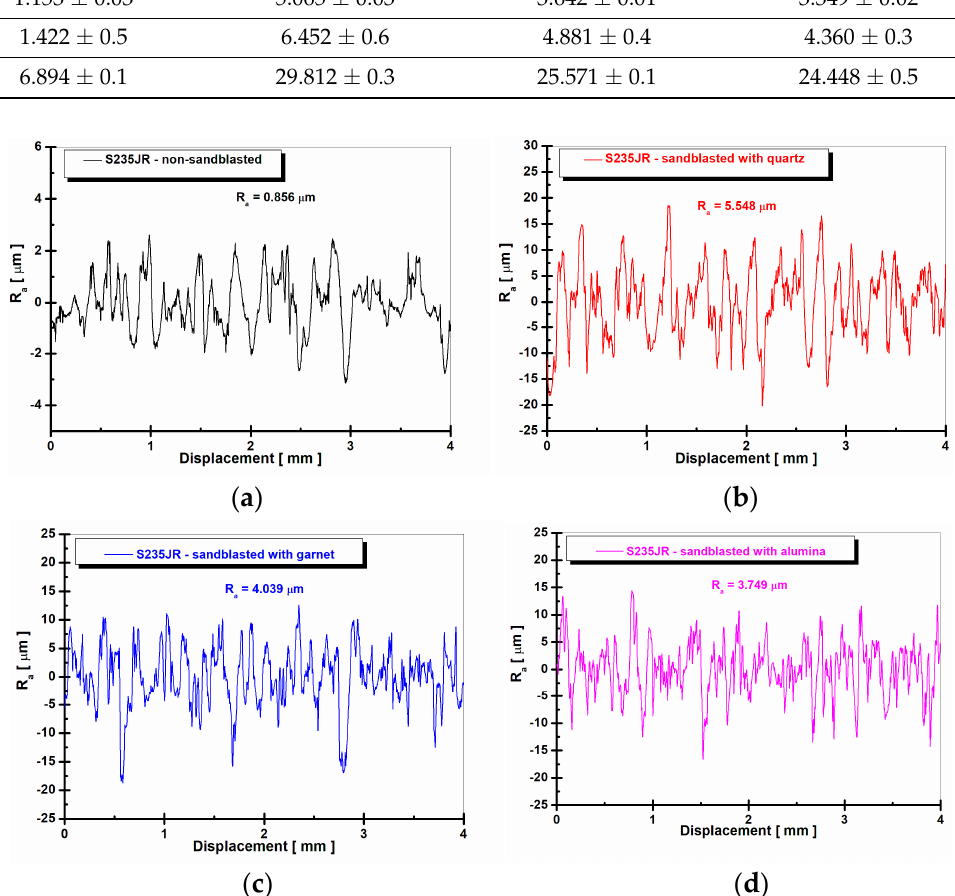
Figure 6. 2D surface profile of surface roughness before corrosion for: ( a ) S235JR—non-sandblasted, ( b )—S235JR—sandblasted with quartz, ( c )—S235JR—sandblasted with garnet, ( d )—S235JR—sandblasted with alumina.